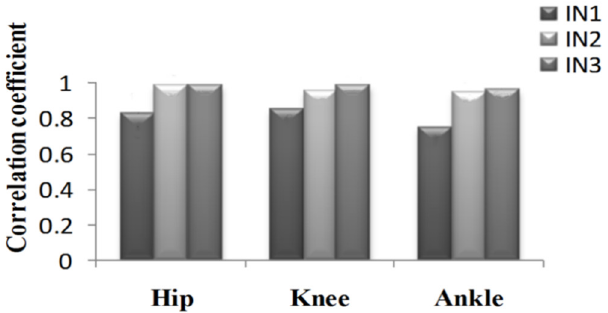
Figure 23. RMSE of the prediction results in the going downstairs process.